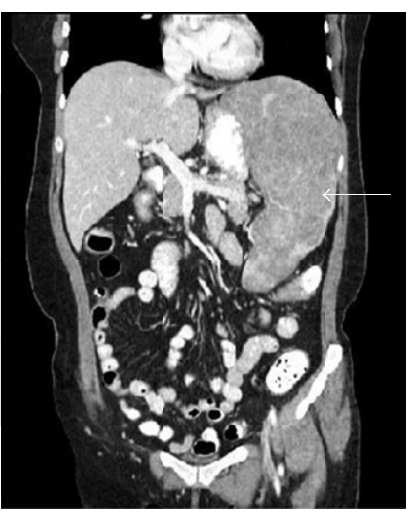
Figure 1: CT scan shows marked enlargement of the spleen and heterogeneous composition and demonstrates low attenuation masses.